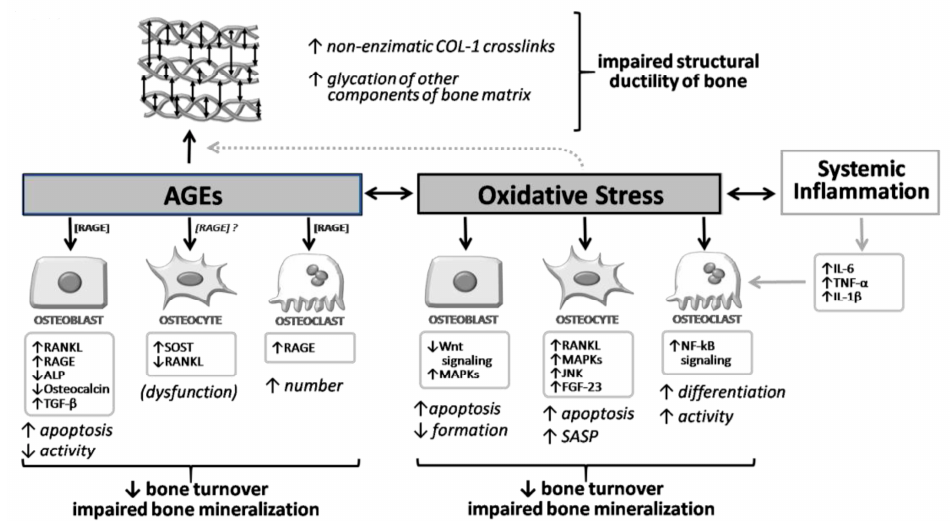
Figure 2. Overview of the molecular and cellular effects of AGEs and oxidative stress on bone. AGEs and oxidative stress exert direct effects on osteoblast, osteocyte, and osteoclast. Moreover, AGEs also increase non-enzymatic crosslinks of collagen type 1 and the glycation of other components of the bone matrix, impairing the structural ductility of bone. This process isenhanced by oxidative stress conditions. ↓ , decrease; ↑ , increase.